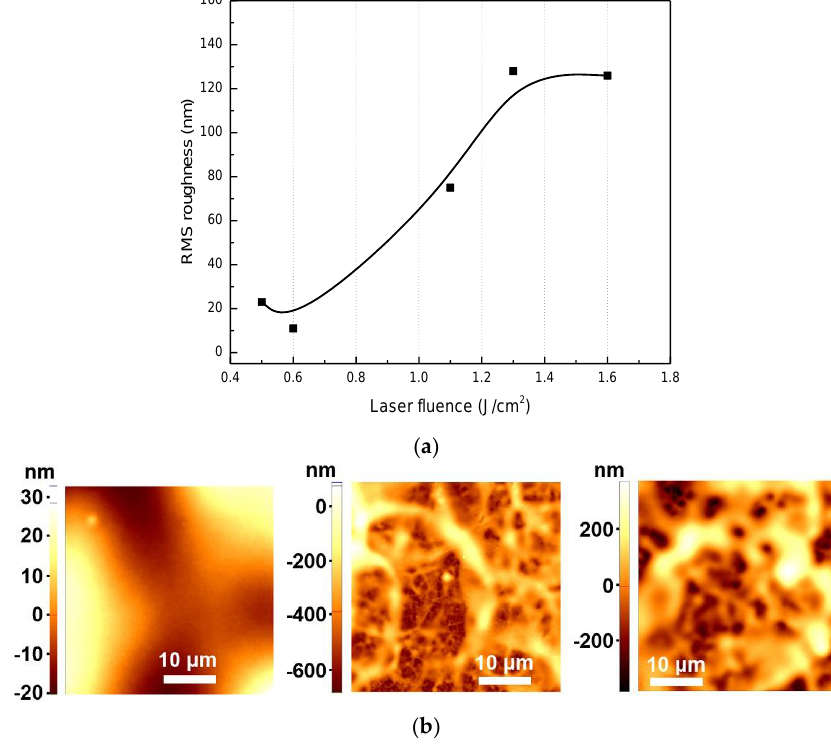
Figure 3. ( a ) The RMS roughness determined for areas of 40 × 40 µm 2 for shellac films deposited by MAPLE. The line between the points is for eye-guidance; ( b ) From left to right: AFM images for 0.6, 1.3, and 1.6 J/cm 2 .